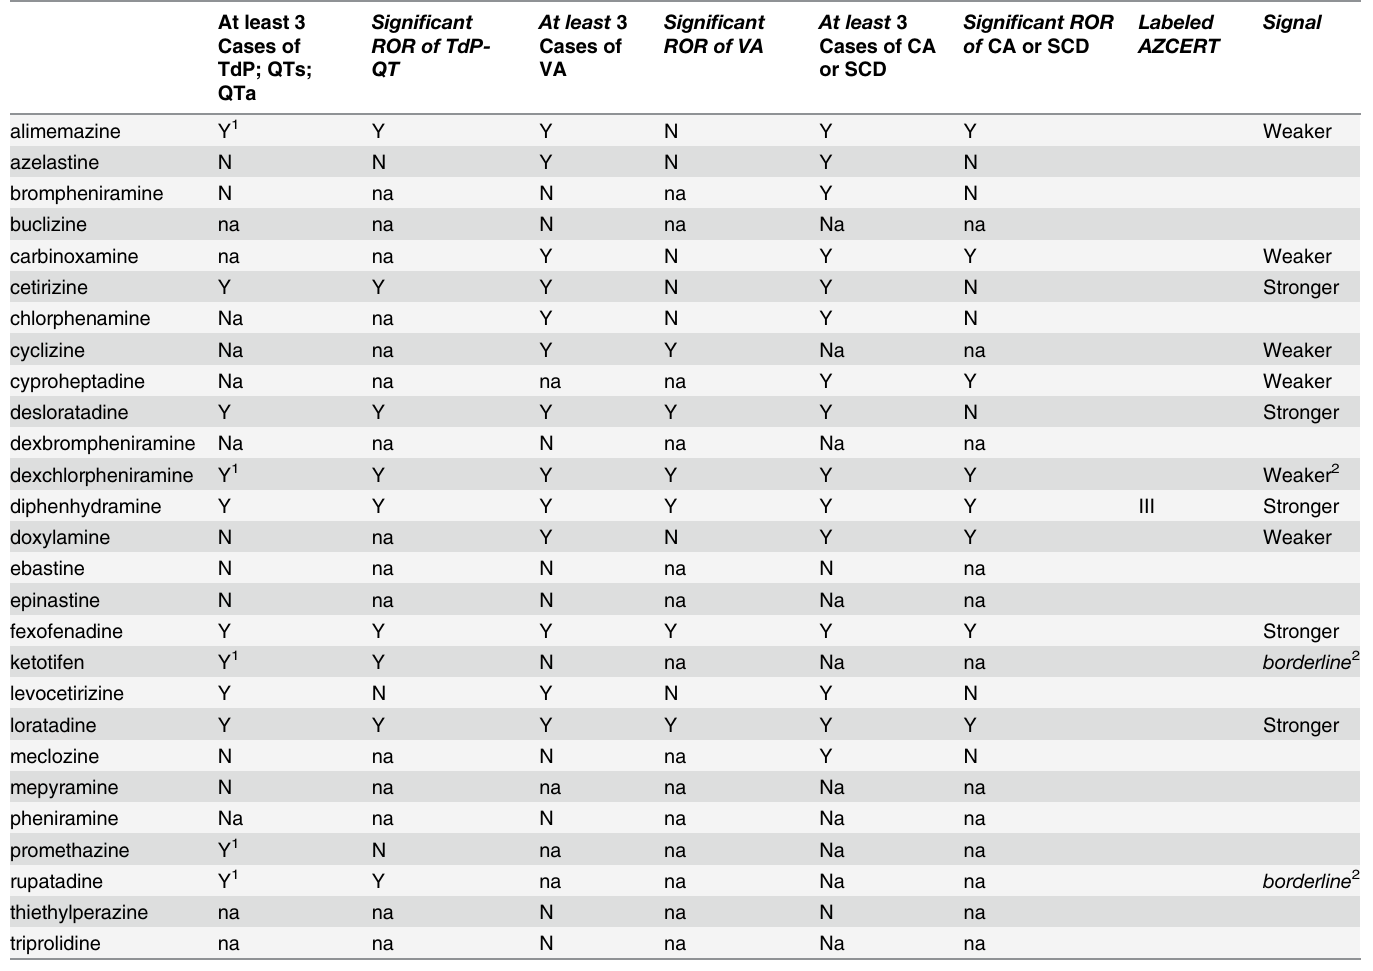
Table 4. Integration of results from different outcomes for signal identi fi cation. At least 3 Cases